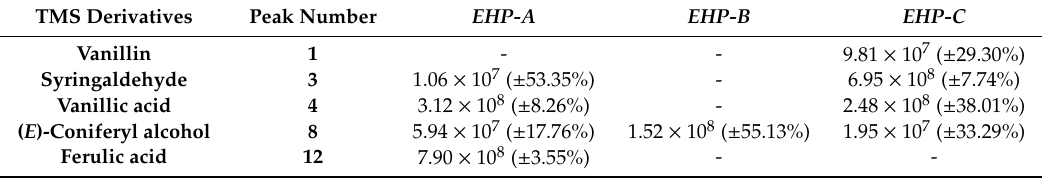
Table 3. Peak areas (mean value ± %SD) for the EHP-quantified compounds ( n = 3). TMS